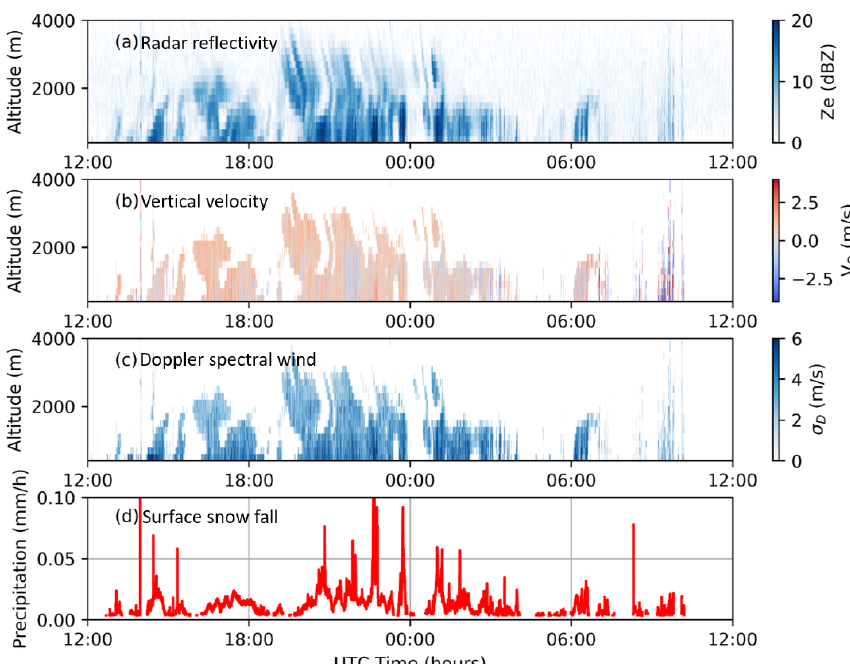
Figure 13. Altitude versus time contour plots of the (a) radar reflectivity, (b) vertical velocity, and (c) Doppler spectral width derived from the MRR-2 Doppler spectra over 24h between 16 February 2018 at 12:00 and 17 February 2018 at 12:00UTC derived using the schemes detailed in Maahn and Kollias (2012). The corresponding empirical estimate of surface snowfall is identified in panel (d) .